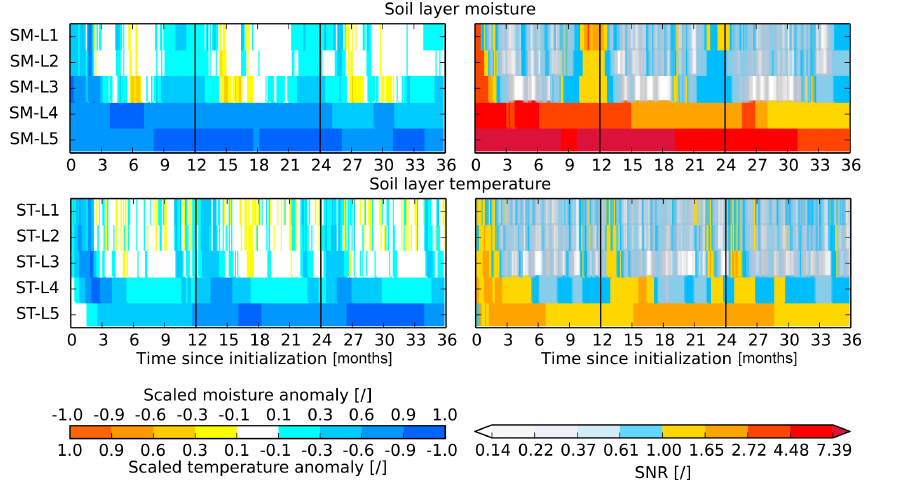
Figure 13. Time series of ensemble mean (cid:49)θ 0 and SNR for a grid cell at − 2.8 ◦ N and 13.12 ◦ E (Republic of Congo) of the wet initialization September ensemble. The upper and lower panels show soil moisture and soil temperature, respectively, for all soil layers. The anomaly notation is mirrored for the soil temperature. Note, that the SNR colour spacing is logarithmic in order to display the ratio similar to a normal distribution. All yellow and red patches in the right panels indicate time periods defined as